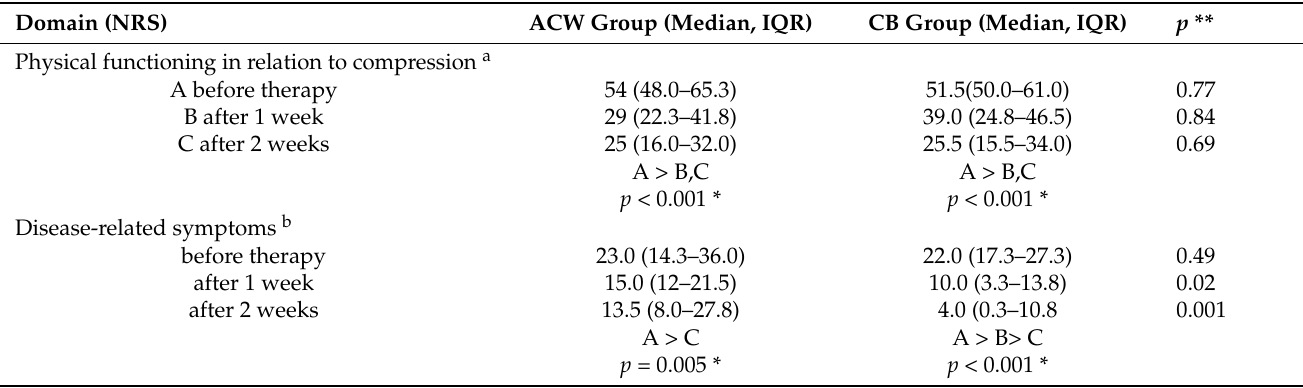
Table 3. Patients’ functioning, symptoms and complications of